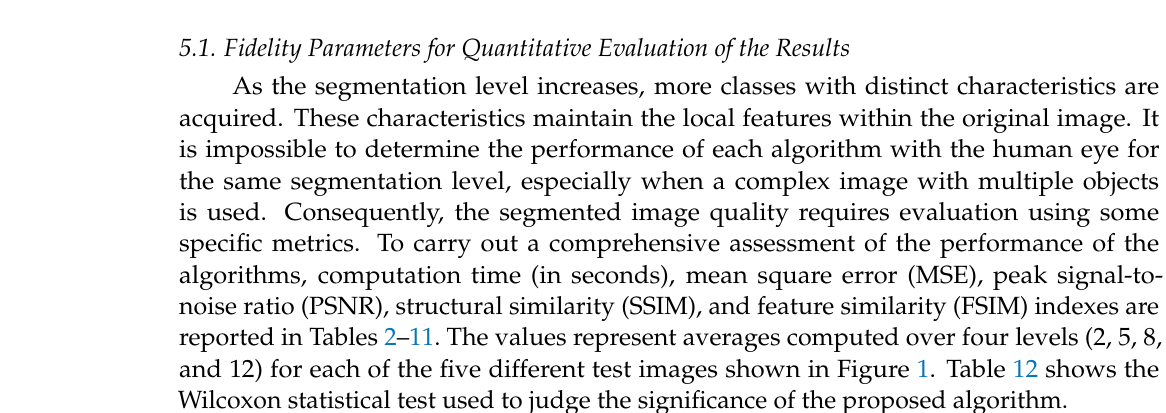
Table 2. CPU time using different optimization algorithms with the EC-Otsu and MCE entropy methods. Images